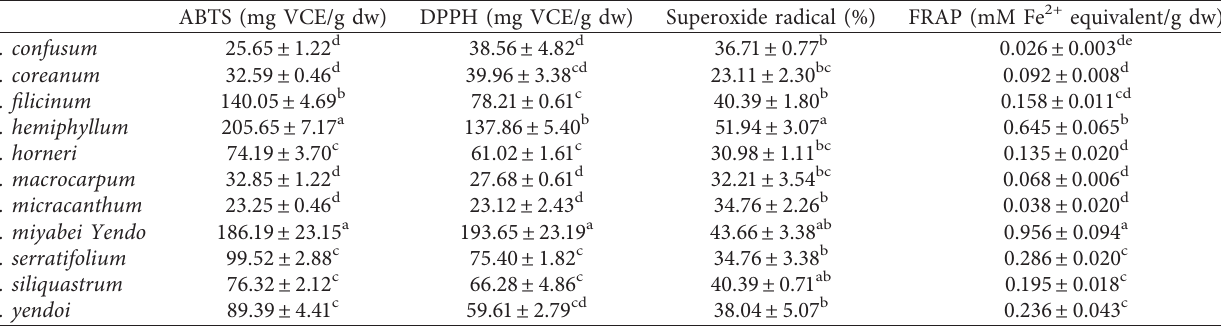
Table 2: Antioxidant capacity of Sargassum species.